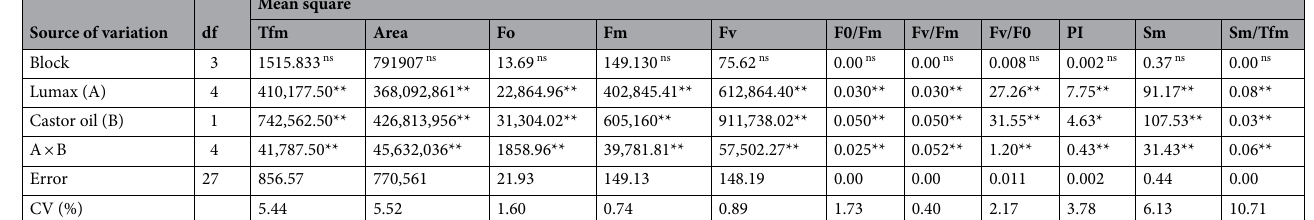
Table 3. Analysis of variance for all chlorophyll a fluorescence parameters of Solanum nigrum in response to different doses of Lumax with and without Castor oil. ns,*,**: No significant and significant at P ≤ 0.05 and P ≤ 0.01, respectively.